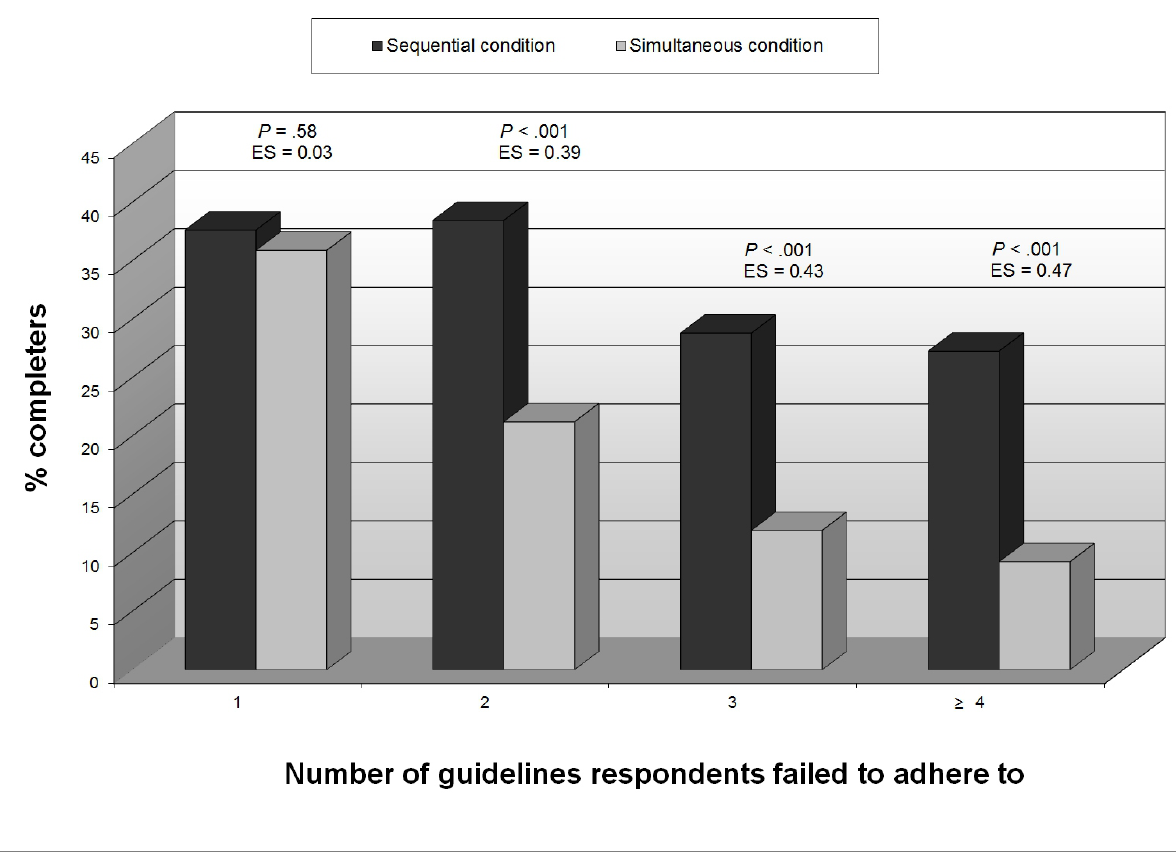
Figure 6. Number of guidelines respondents failed to adhere to against the number of completers in the sequential condition (n = 1536) and the simultaneous condition (n =